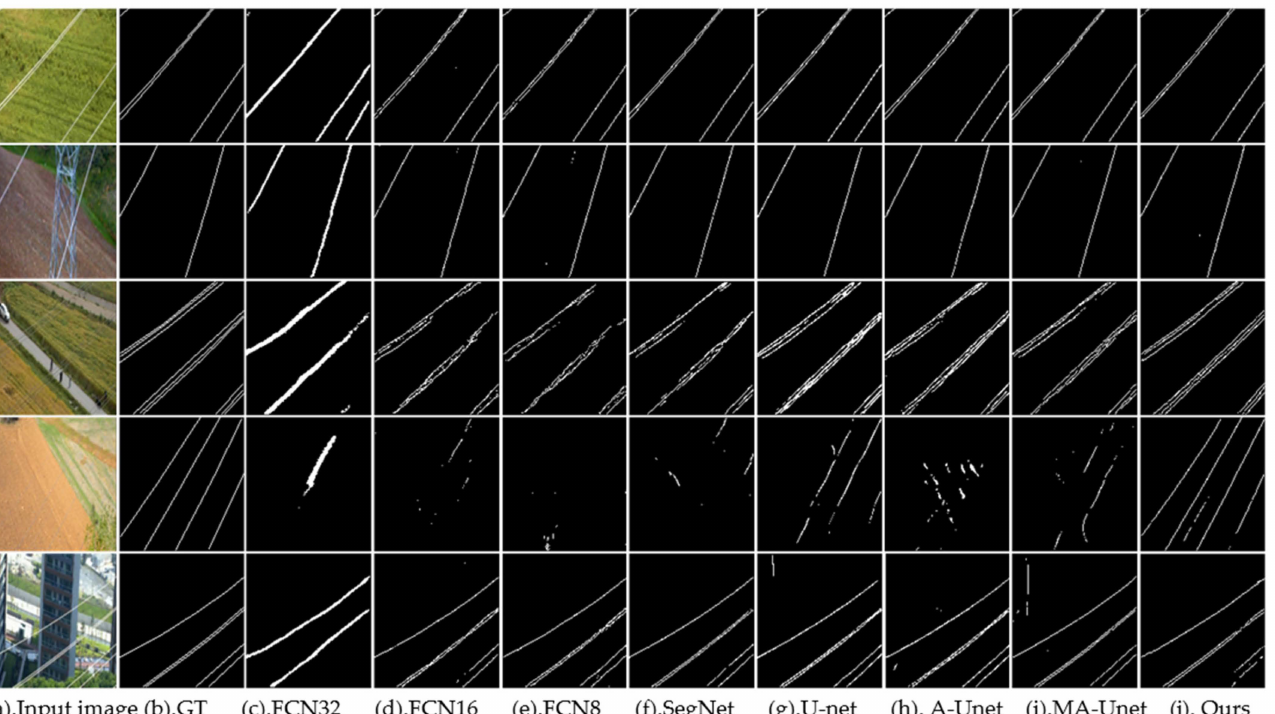
Figure 3. The PLE results of datasets containing power lines. The more similar the extracted images ( c – j ) with the GT ( b ) denotes the better performance of the method